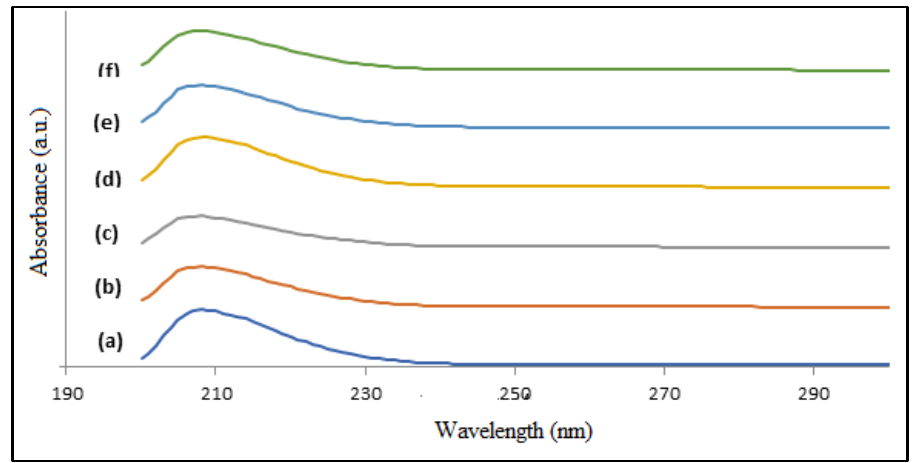
Figure 7. UV-vis spectra for PPVA-AlPO 4 nanocomposite samples at different pH values ( a ) 7; ( b ) 8; ( c ) 9; ( d ) 10; ( e) 11; ( f ) 12.